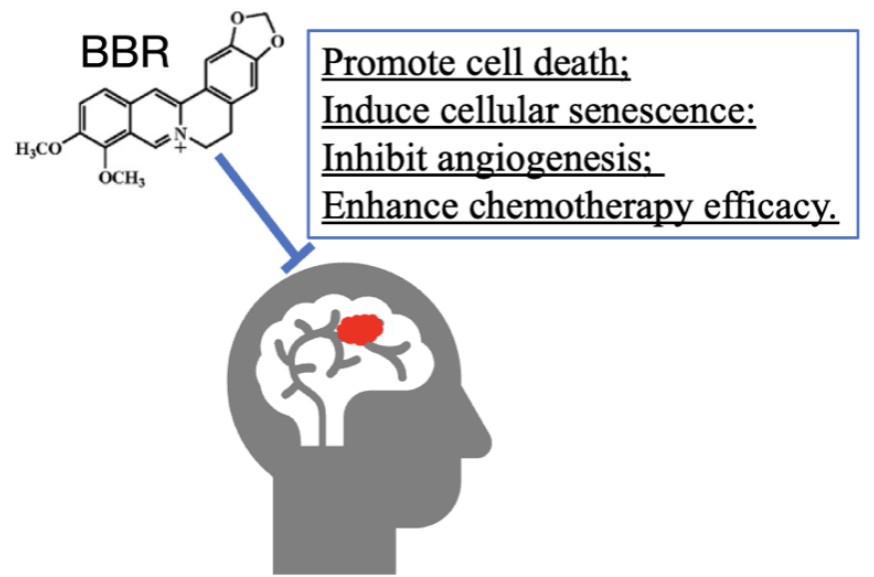
Figure 5. Effects of BBR against brain tumor.